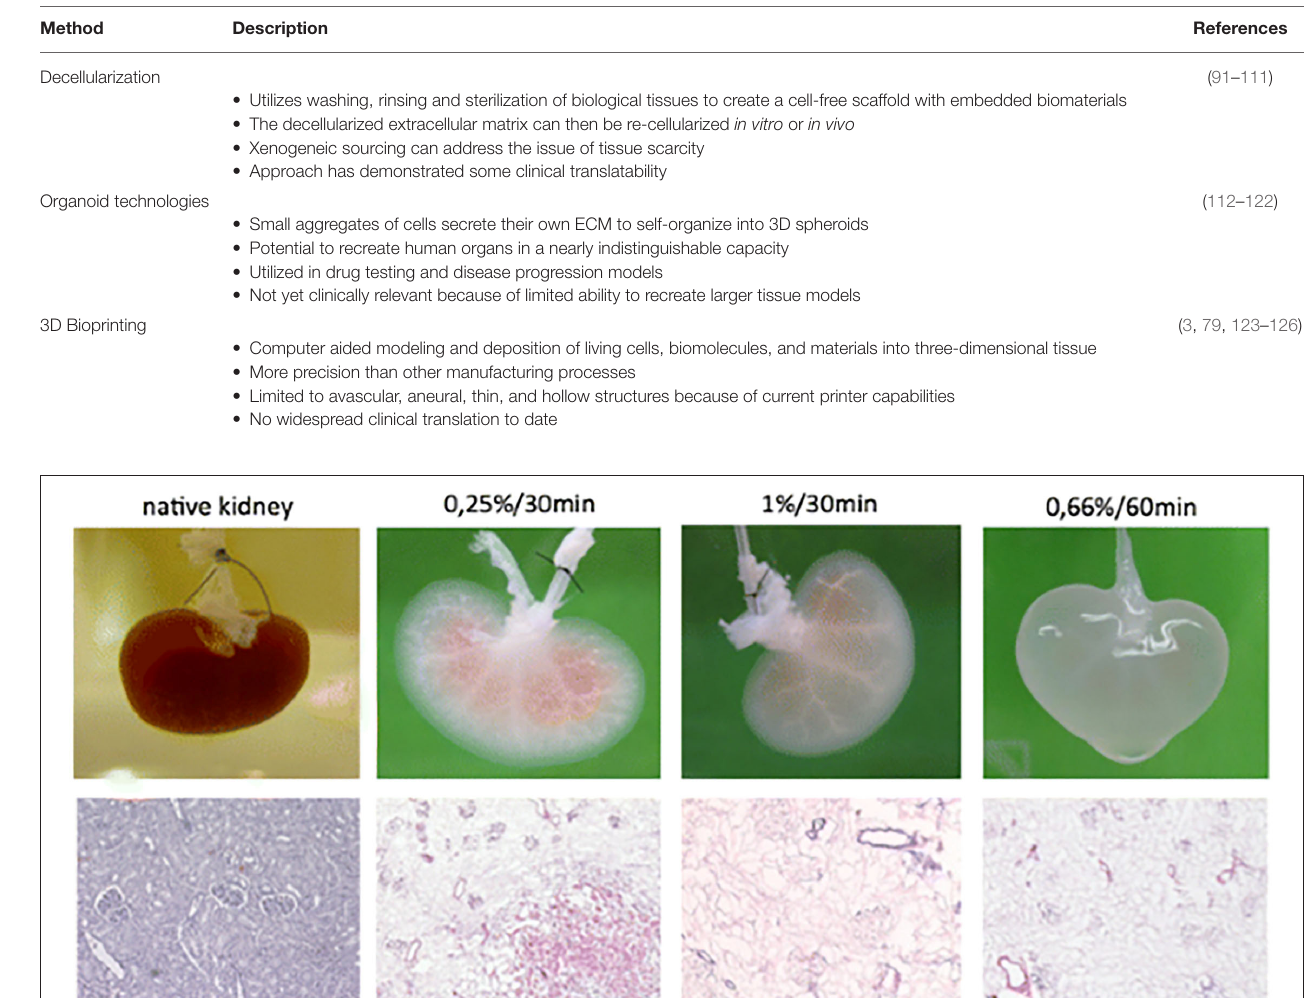
TABLE 3 | Summary of manufacturing methods.